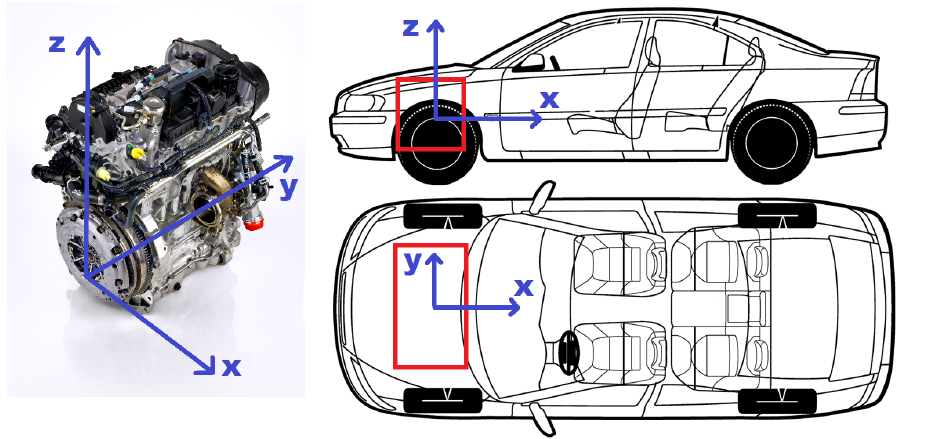
Figure 1. Powertrain and vehicle coordinate systems. The red rectangle represents the powertrain’s position within the